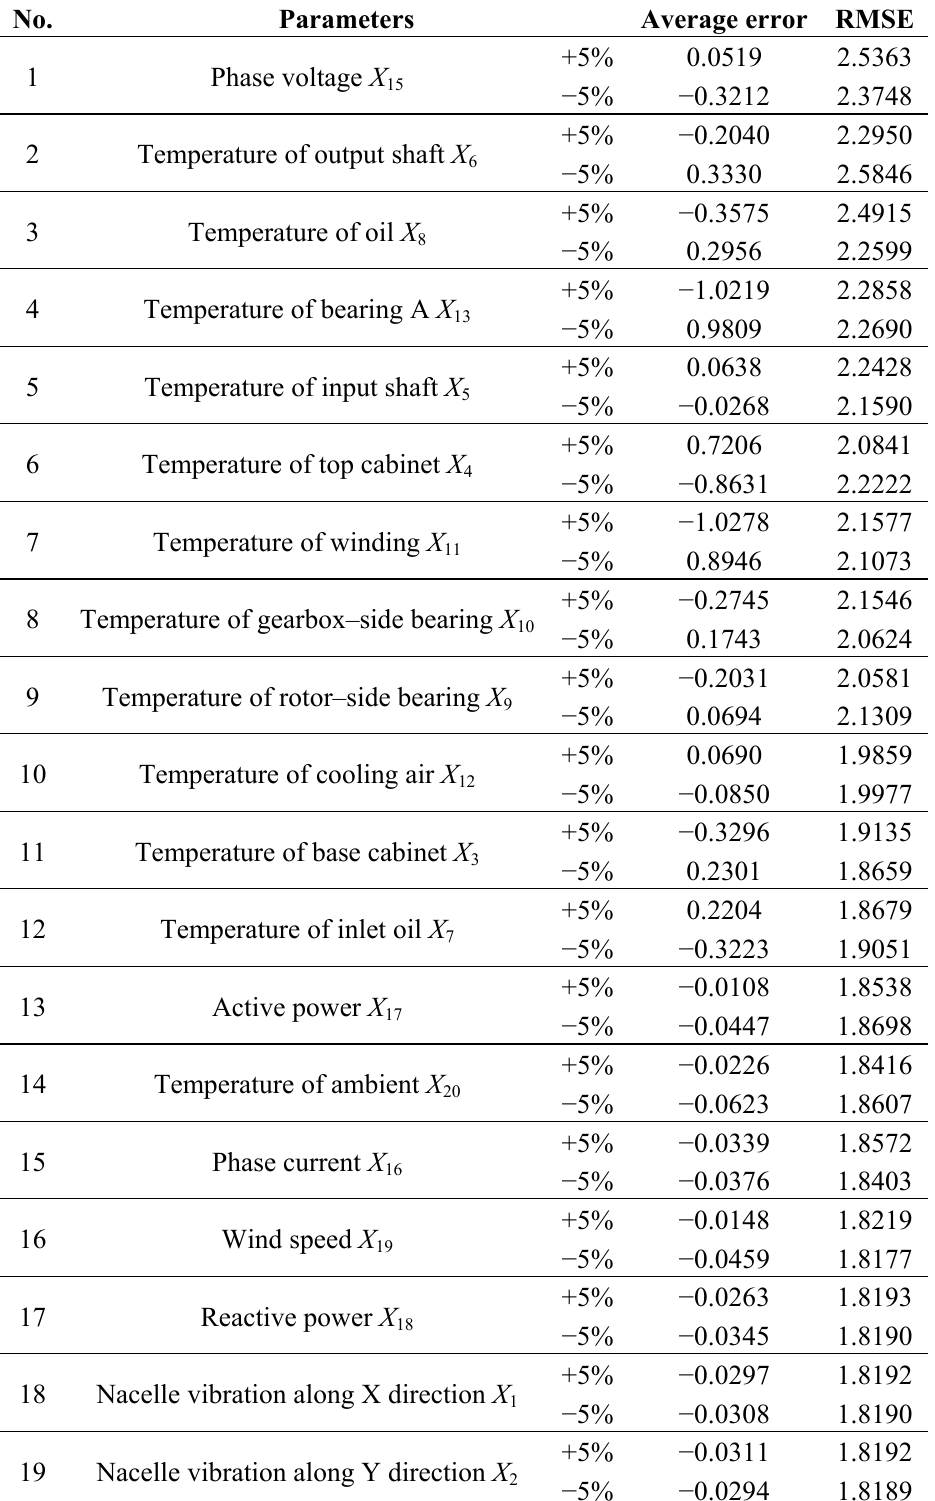
Table 2. Influence of the parameters on the temperature of generator bearing